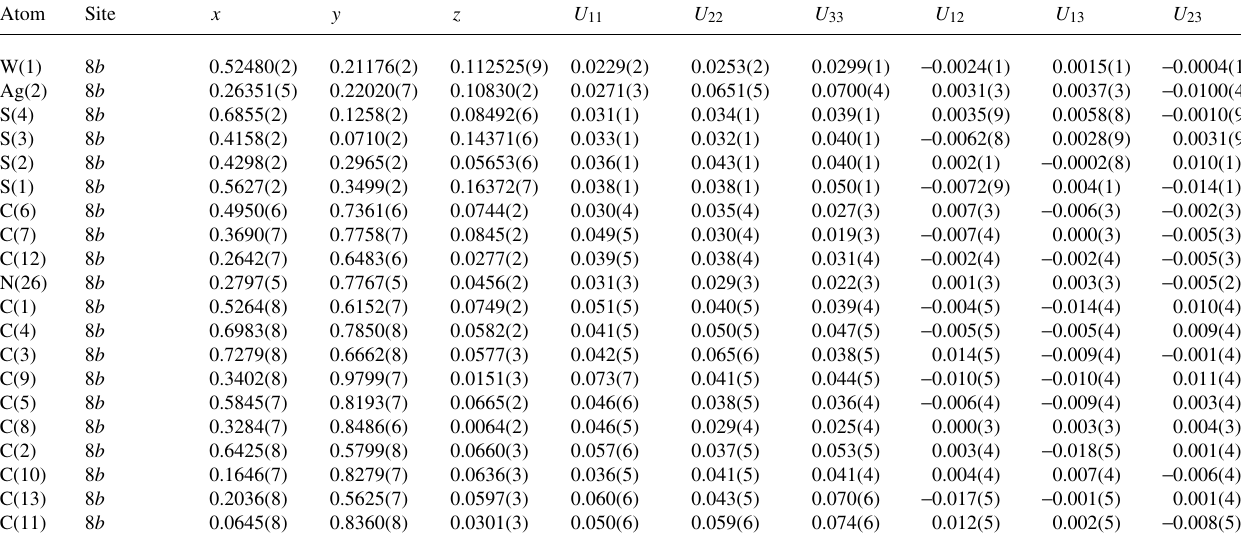
Table 3. Atomic coordinates and displacement parameters (in Å 2 ) .